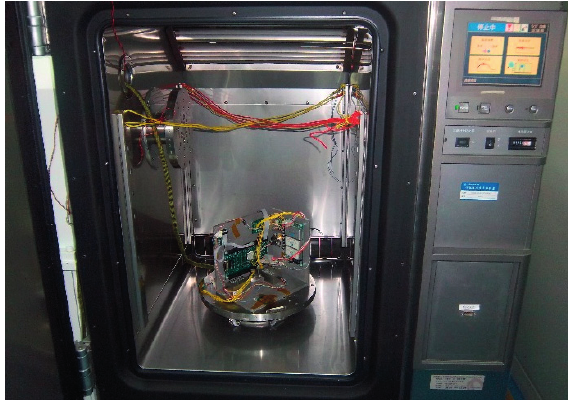
Figure 5. The photo of experimental